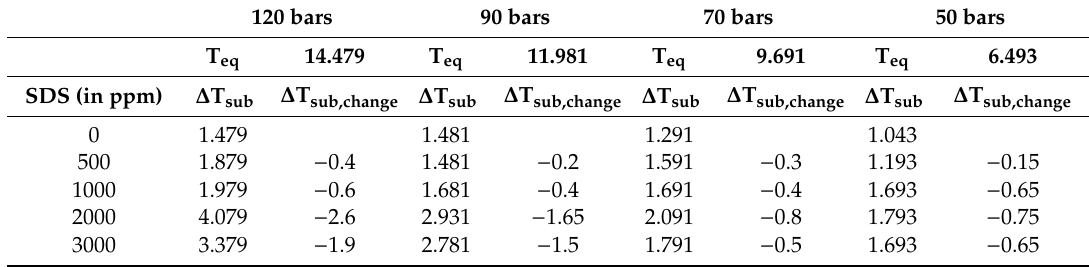
Table 5. Calculation of ∆ T sub and ∆ T sub,change for fresh SDS solution.